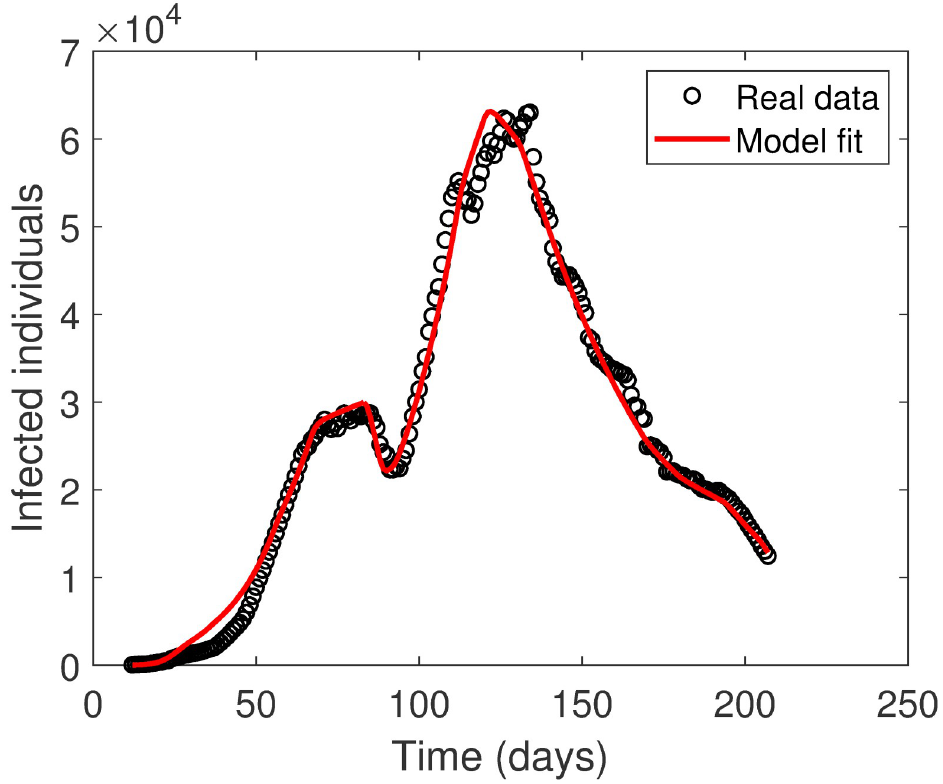
Fig 3. Fitting model (1) for COVID-19 active cases in Saudi Arabia from March 12, 2020, till September 23, 2020.